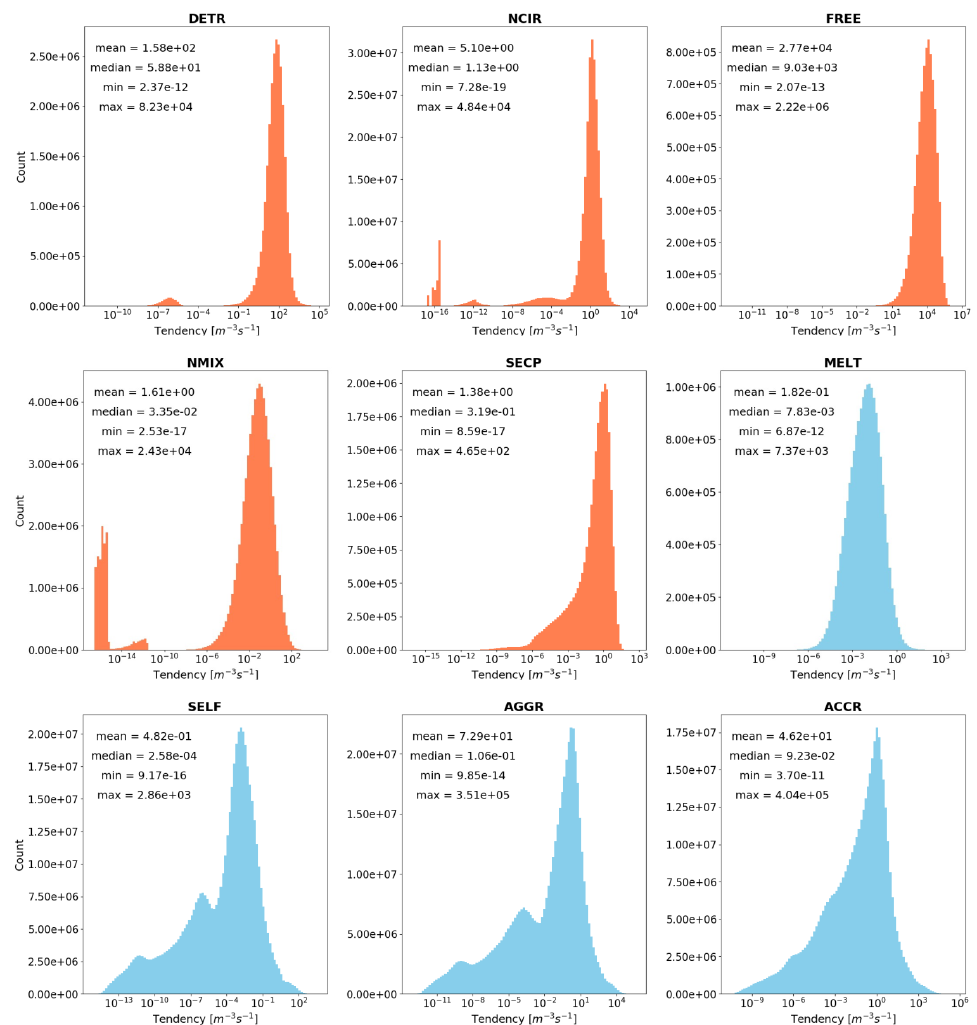
Figure 4. Occurrence and statistics of ICNC tendencies (REF). The bar charts are computed with 5h output data distributed in 100 logarithmic bins. For each tendency, only values grater than zero have been considered in the analysis (absolute values are used for the sinks). The vertical axis shows the occurrence in linear scale; the horizontal axis shows the tendency values in logarithmic scale. Warm colour tones indicate sources of ICs, while cold colour tones indicate sinks of